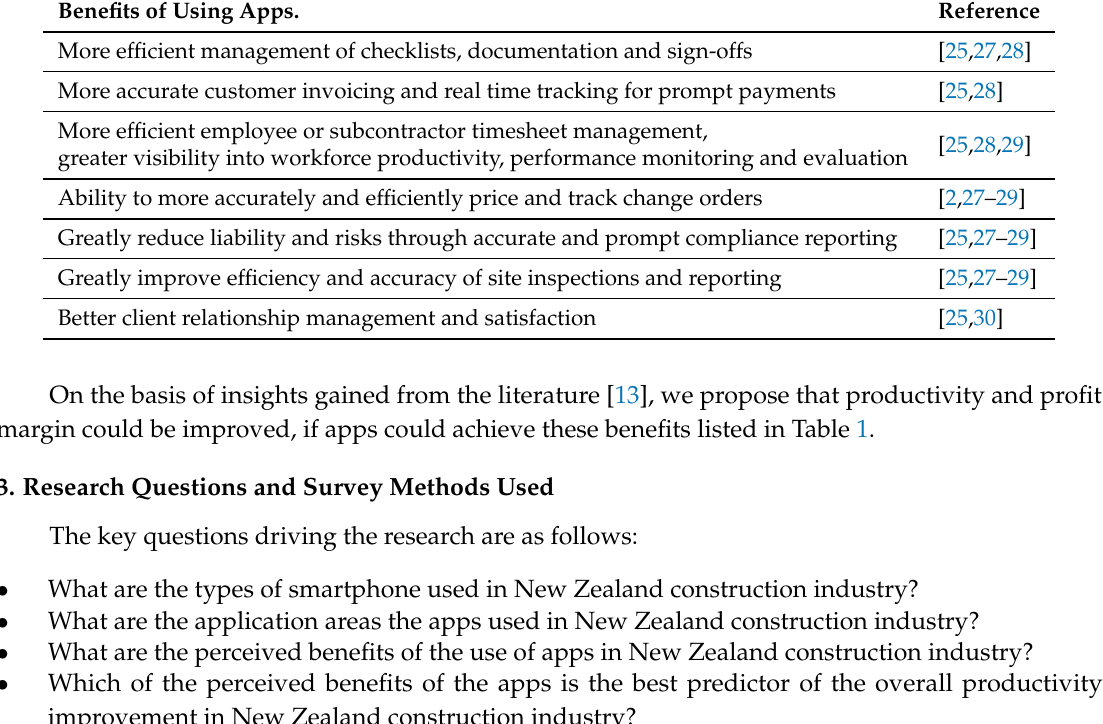
Benefits of Using